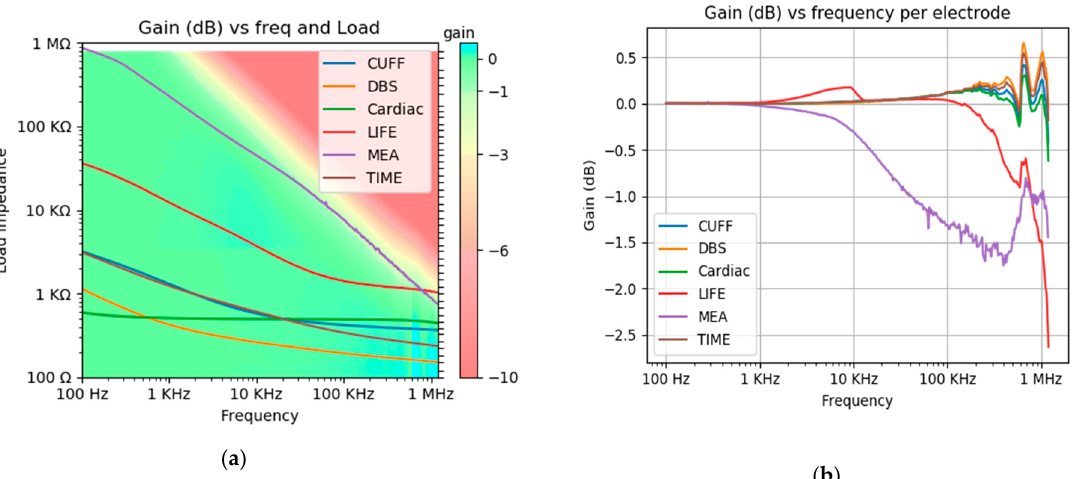
Figure 11. ( a ) Current gain between the generated current measured on a resistive load and the targeted current amplitude programmed on the stimulation system, versus frequency and load. The gain range is color-coded. Ticks on the right y-axis indicate the load values used to compute the colored surfaces. Impedance spectroscopic measurements performed on different types of electrodes are superimposed (color curves). ( b ) Gain versus frequency for each electrode, based on electrode impedance spectroscopy curves from (a).